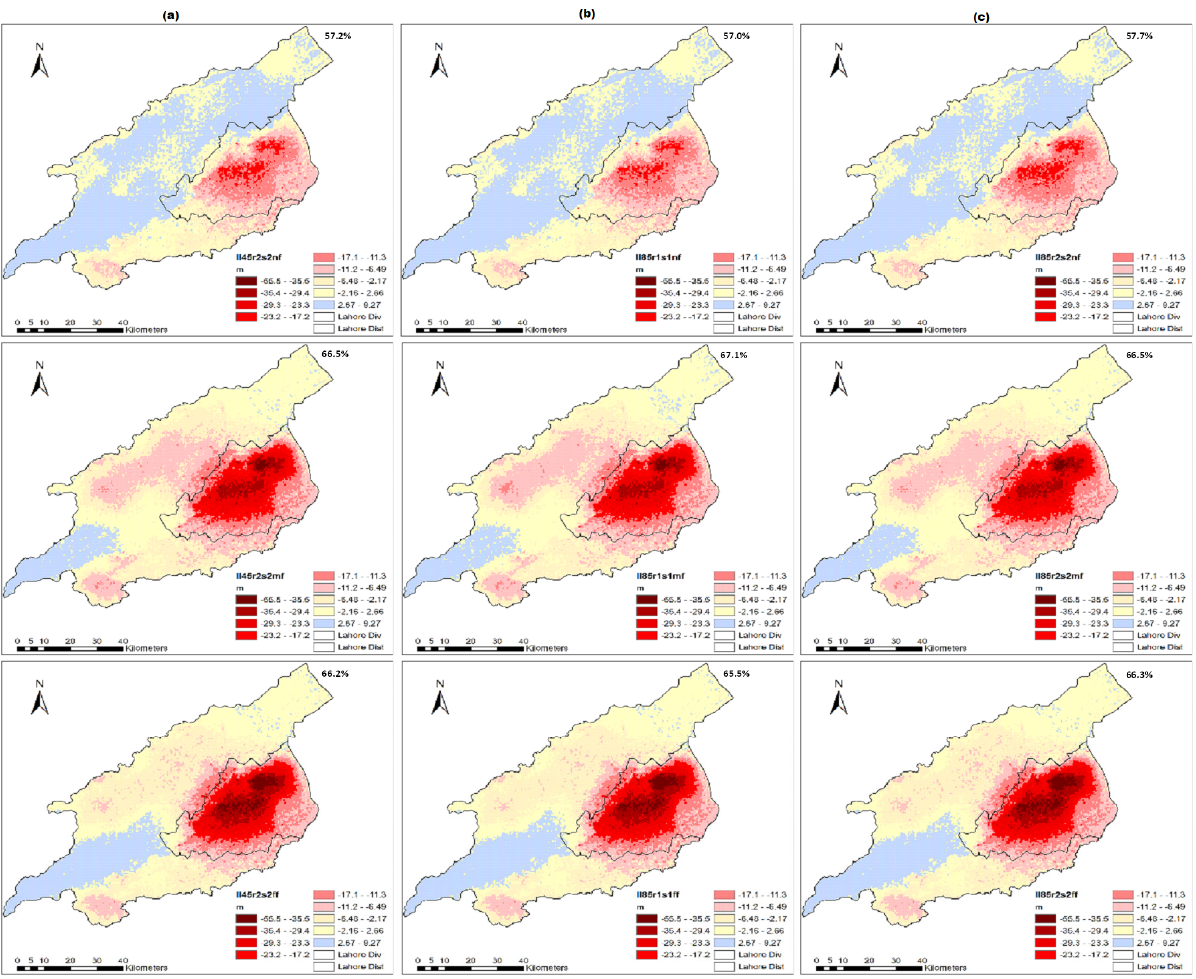
Figure 11. Future impact of climate change, land use change and abstraction on groundwater resources of Lahore under RCP4.5R2S2SSP1 ( a ), RCP8.5R1S1SSP3 ( b ) and RCP8.5R2S2SSP3 ( c ) scenarios.